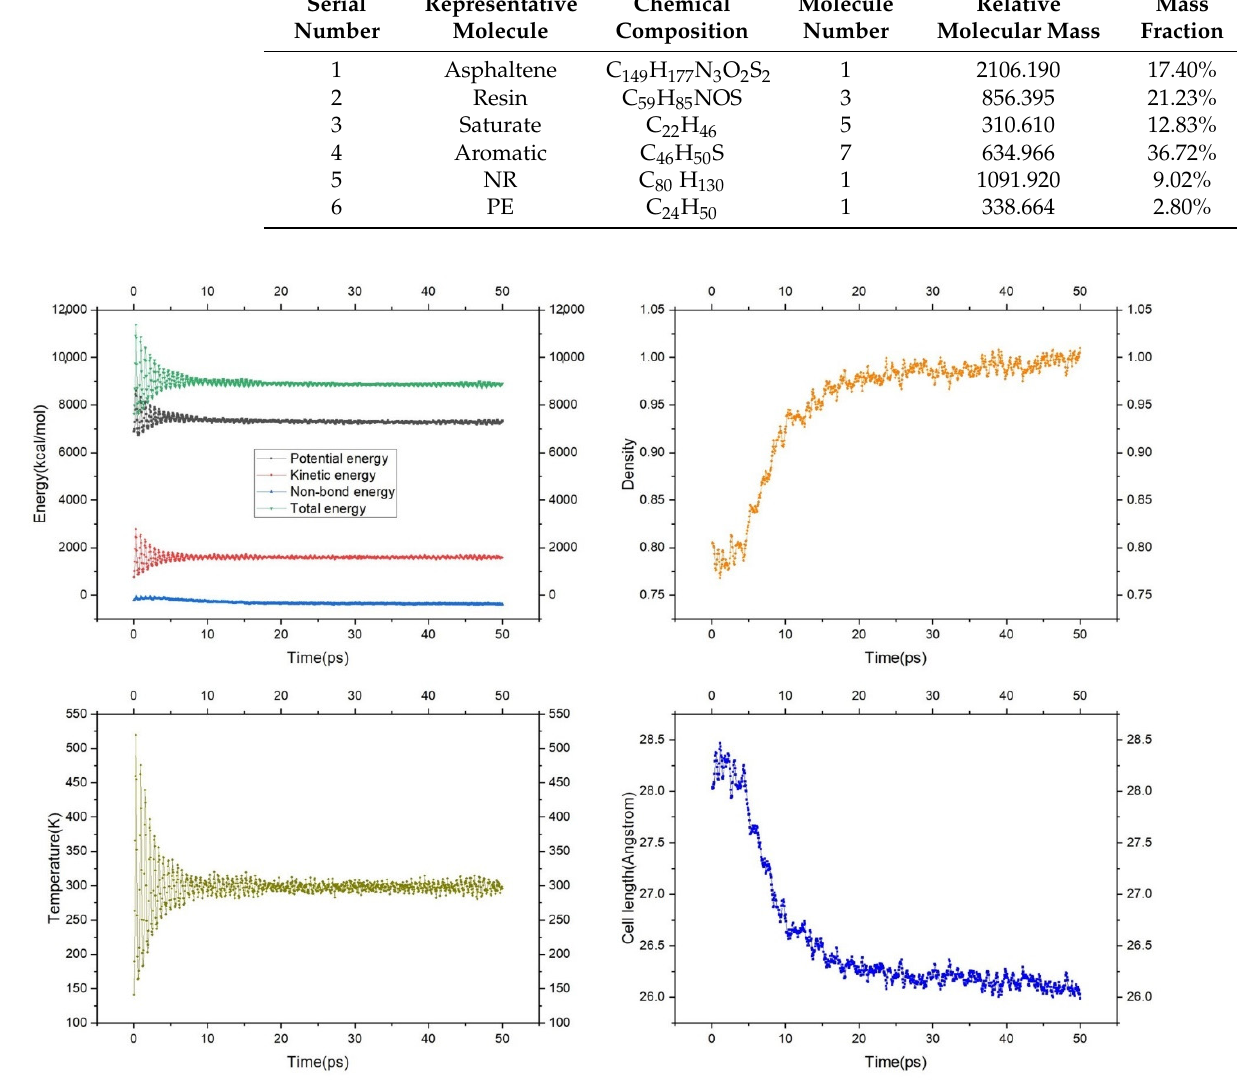
Figure 4. Dynamic equilibrium process.